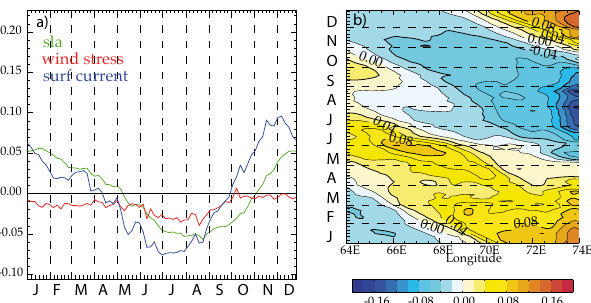
Fig. 9. Remote forcing in IND region. (a) Seasonality of along- shore surface current (ms − 1 , positive (negative) values indicate northwestward (southeastward) flow), sea level anomaly (m) and wind stress (m − 2 s − 2 ). (b) The time–longitude section of sea level anomaly (m) between January and December, highligting the westward propagation of Rossby waves generated along the southwest- ern coast of India.